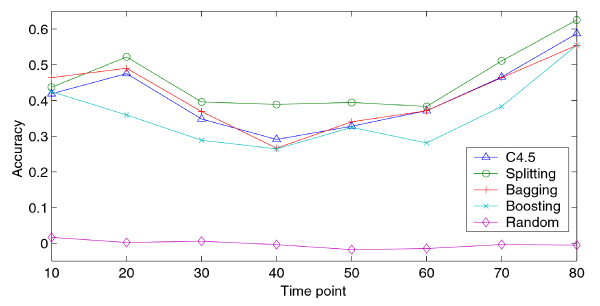
Ten-fold cross-validation accuracy of C4.5, Bagging, Boosting and Splitting. Experiments were done on eight different time points of CDC28 data set. Implementation of Bagging, Boosting and C4.5 were obtained from the WEKA package [52]. C4.5 was also used as the base level classifier for Bagging, Boosting and Splitting. Default parameters were used for C4.5, Bagging and Boosting. Splitting were done according to Materials and Methods.